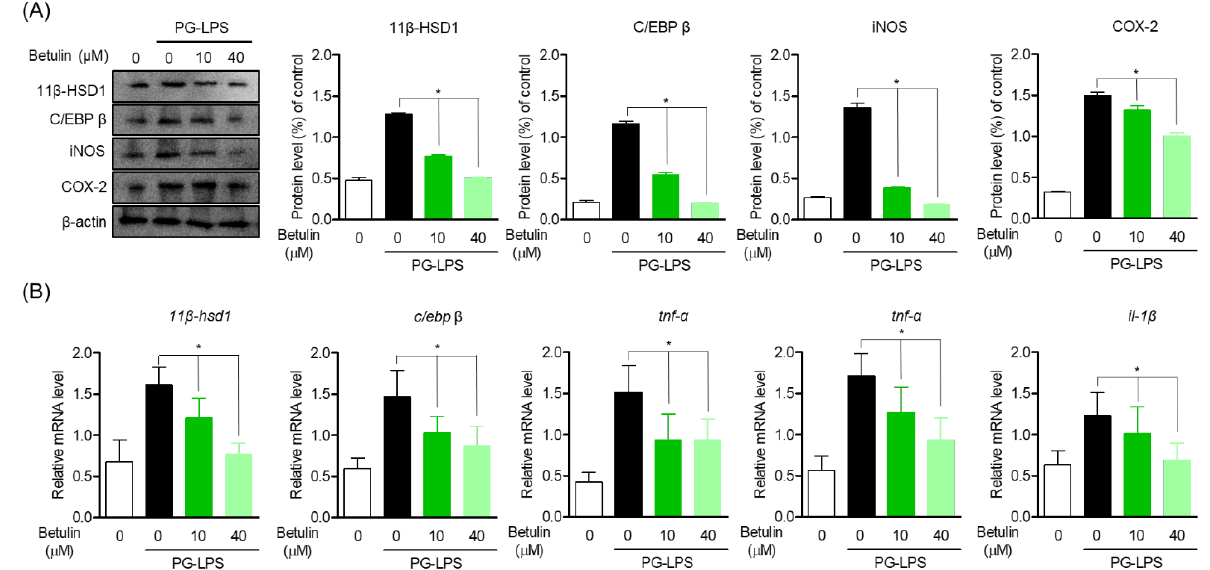
Figure 4. Inhibitory Effect of Betulin on Inflammatory Mediators by Regulating 11β -HSD1 and C/EBP Activities. The cells (1 × 10 6 cells/mL) were pre-treated with 10 and 40 µ M for the 6 h then after, PG-LPS (1 μg/mL) was treated for the 24 h. The expression of each proteins ( A ) and pro-inflamatory cytokine gene level ( B ) were analyzed by Western blot and real time pcr. * p < 0.05 was considered significant differences between each treated groups.